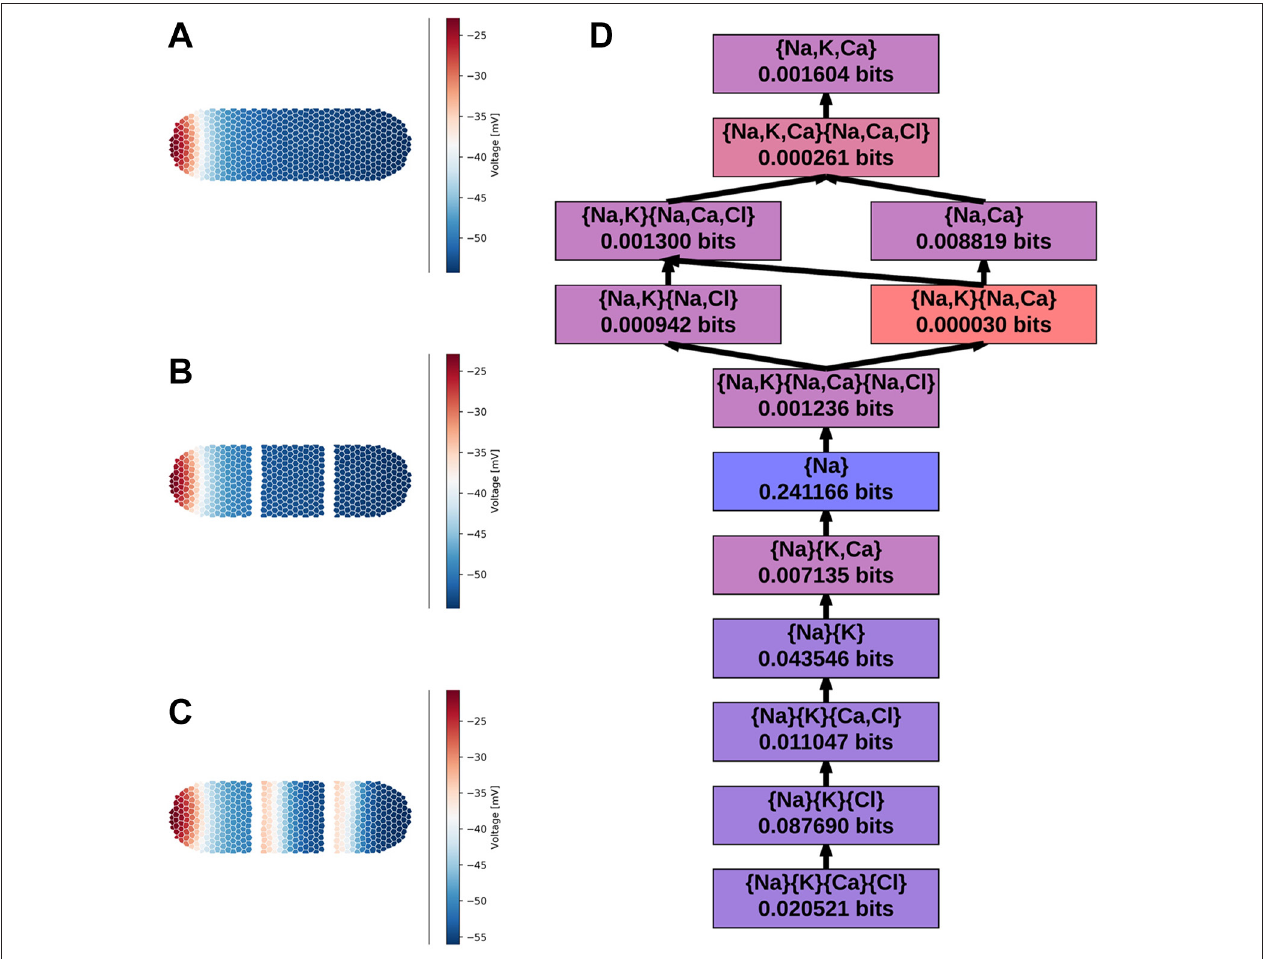
fIguRe 1 | The V mem distribution over the body of a BETSE simulated planarian (Pietak and Levin, 2016) over the course of regeneration: (A) pre-surgery, (B) 0 s post-surgery, (c) 1000 s post surgery. (d) The non-zero redundancy sub-lattice computed via partial information decomposition. Each node presents the redundant information provided by the given collection of random variables. Of the 166 nodes in the full redundancy lattice, these 13 are the only nodes which yield non-zero unique information. All other nodes were pruned, and the edges were constructed using the Williams-Beer dependency relations. Nodes are colored roughly by the order of magnitude of their unique information